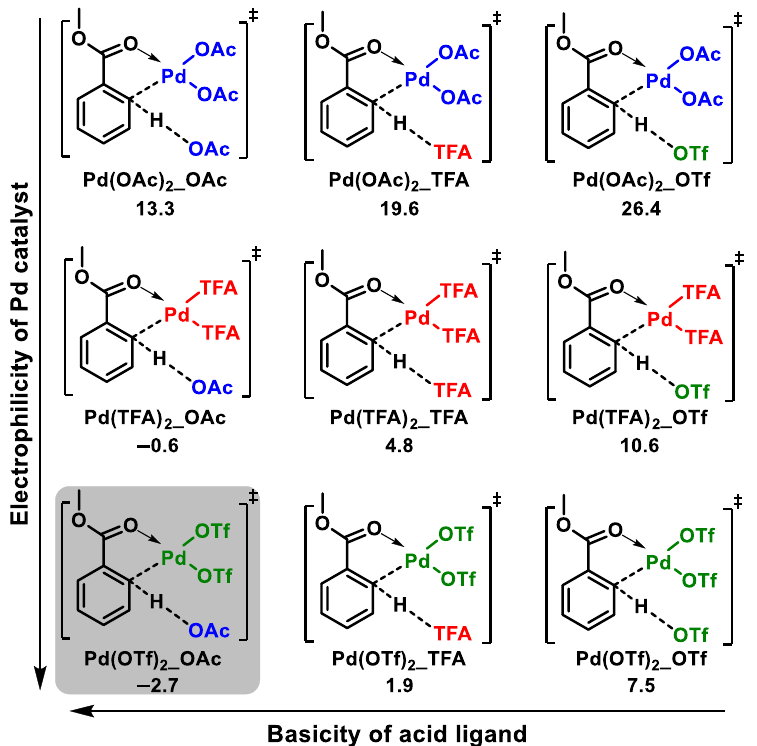
Figure 3. The relative free activation energies (kcal/mol) for the intermolecular models of sub5 with three different Pd catalysts and three different anionic external acid ligands (OAc − , TFA − , TfO − ).